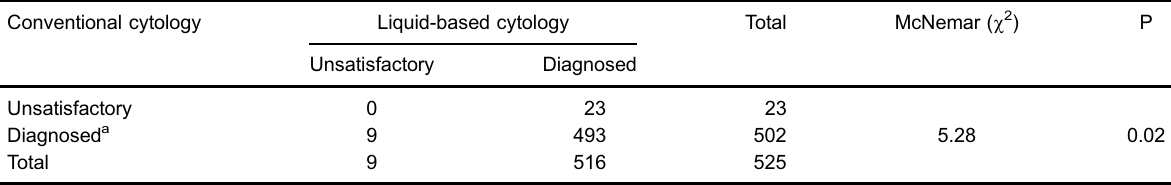
LACEN: Laboratório Central de Saúde Pública do Estado de Pernambuco, Brazil. a Including normal, in fl ammatory, atrophied and altered cytologies (ASCUS/ASC-H/LSIL/HSIL/CA) in situ . ASCUS: atypical squamous cells of undetermined signi fi cance; ASCH: